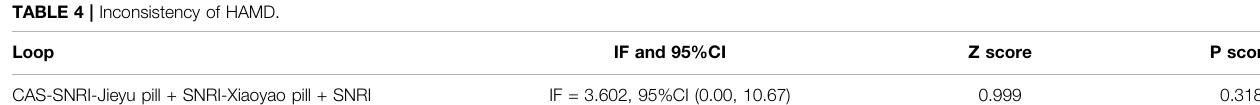
TABLE 4 | Inconsistency of